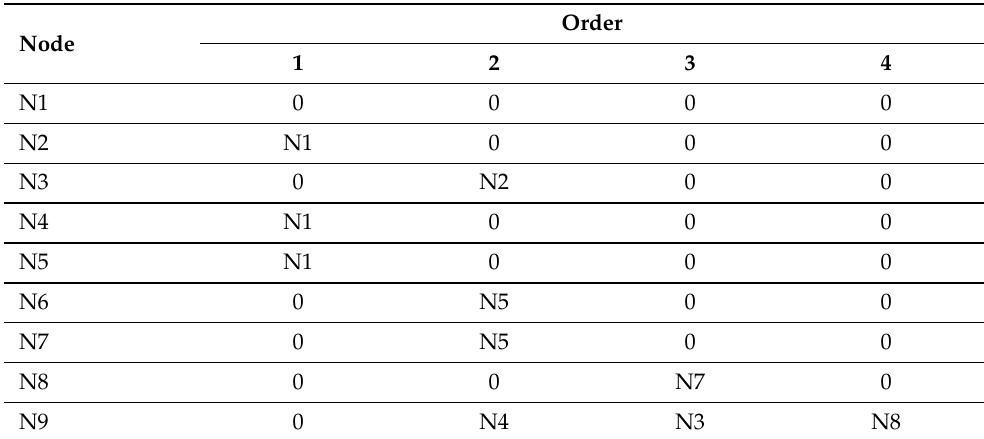
Table 6. Backtrack matrix (E).